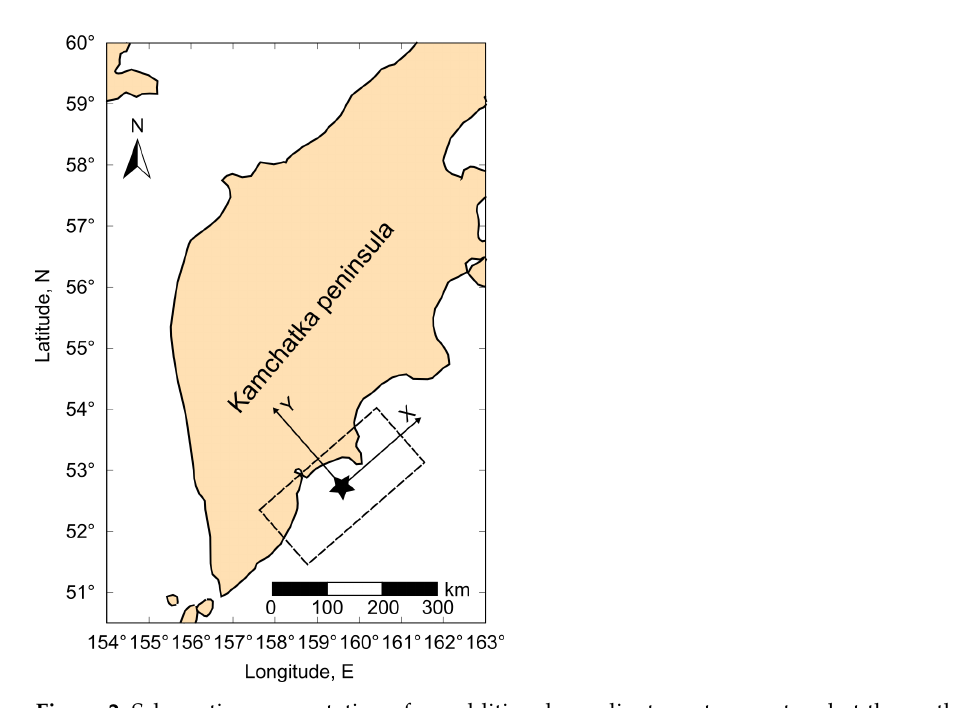
Figure 2. Schematic representation of an additional coordinate system centered at the earthquake epicenter (asterisk). The dotted line is the projection of the fault plane onto the Earth’s surface ( z =